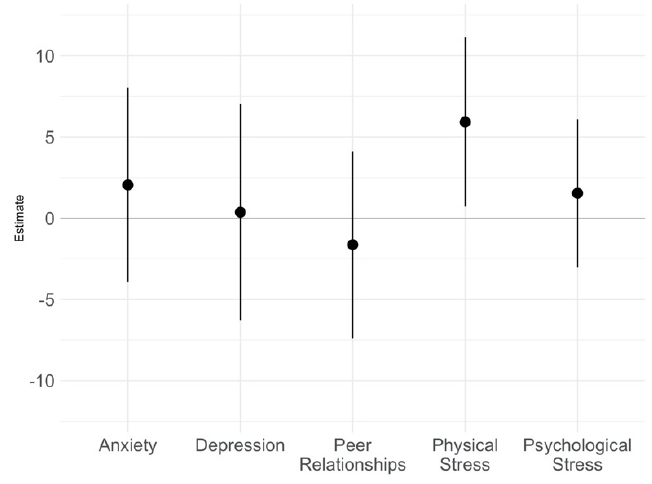
Figure 2. Regression coefficients and accompanying 95% confidence intervals per 10-fold increase in weekly median UFP exposure for PROMIS domain T scores. Models were adjusted for average number of steps per day, maternal education, household income, and season.